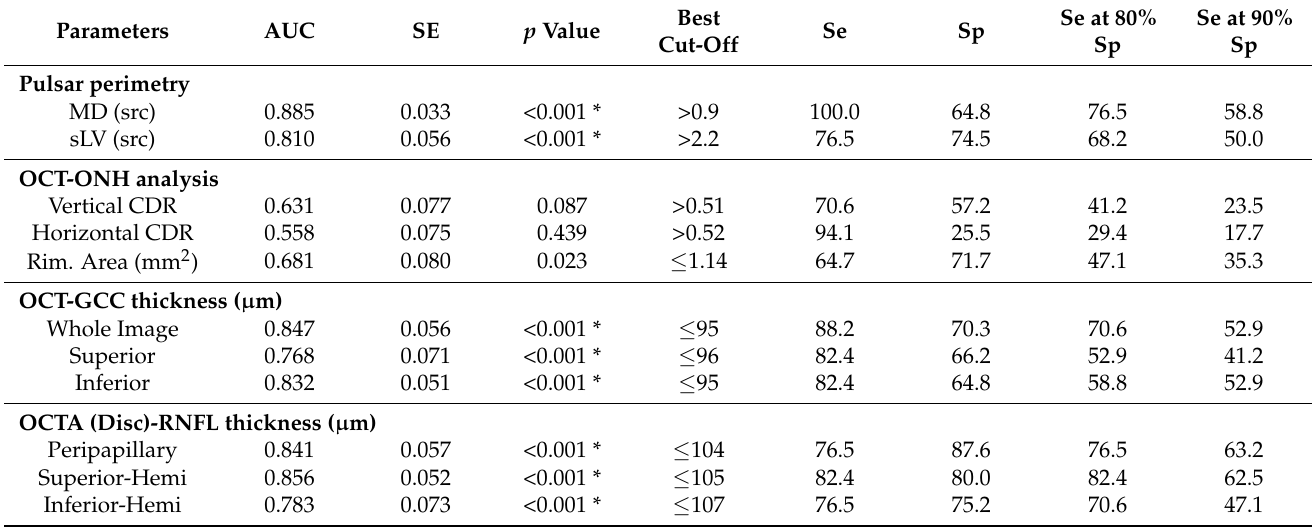
Table 4. Results of receiver operating characteristic analysis between control and perimetric glaucoma